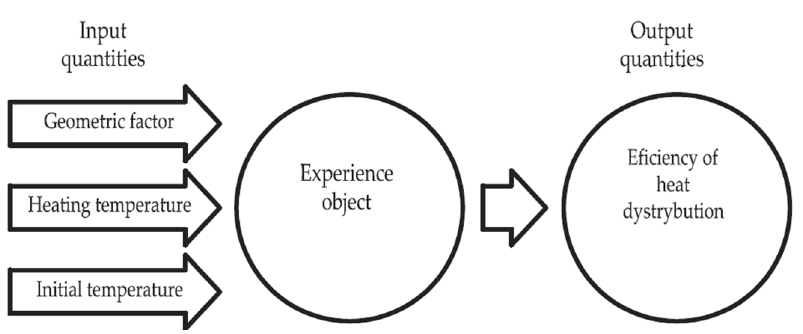
Figure 1. Graphical diagram of the experimental design.